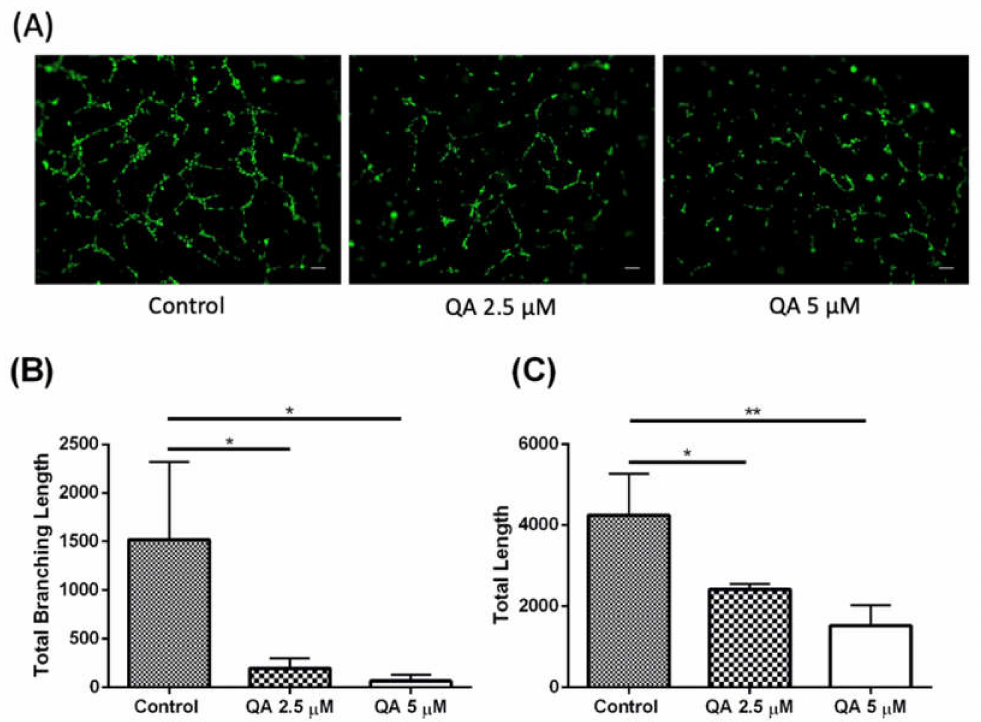
Figure 6. Evaluation of QA e ffi cacy in inhibition of angiogenesis process in human umbilical vein endothelial cells (HUVEC) . ( A ) As compared to control, it can be seen that increasing concentration of QA inhibits tube formation in HUVEC. Highest concentration of QA barely permitted the formation of tubes, which is essential in nutrient provision in tumors. ( B ) Plot represents total branching length in HUVEC after treatment with QA at two concentrations. A significant di ff erence in branching length can be seen as the concentration of QA is increased. ( C ) Plot represents total tube length in HUVEC after treatment with two concentrations of QA. A significant di ff erence is seen in total formed tube length between QA-treated and control group of cells. Data represents mean ± SD ( n = 3), * p < 0.05, ** p < 0.01, compared between treatment and control groups, as indicated, Scale Bar 200 µ